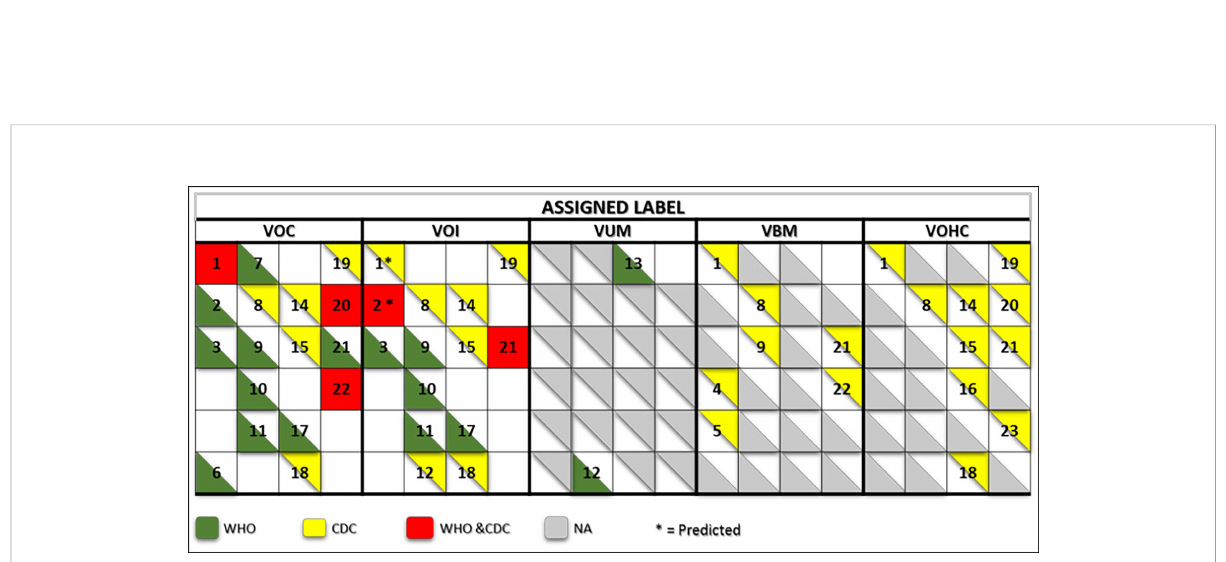
FIGURE 2 Matrix showing the commonalities and discrepancies of the criteria used by WHO and the CDC to label SARS CoV-2 variants. The green and yellow triangles indicate the criteria used by WHO and the CDC, respectively. The red squares indicate the criteria used by both agencies for a same label. The numbers correspond to the labeling criteria displayed in Table 1.